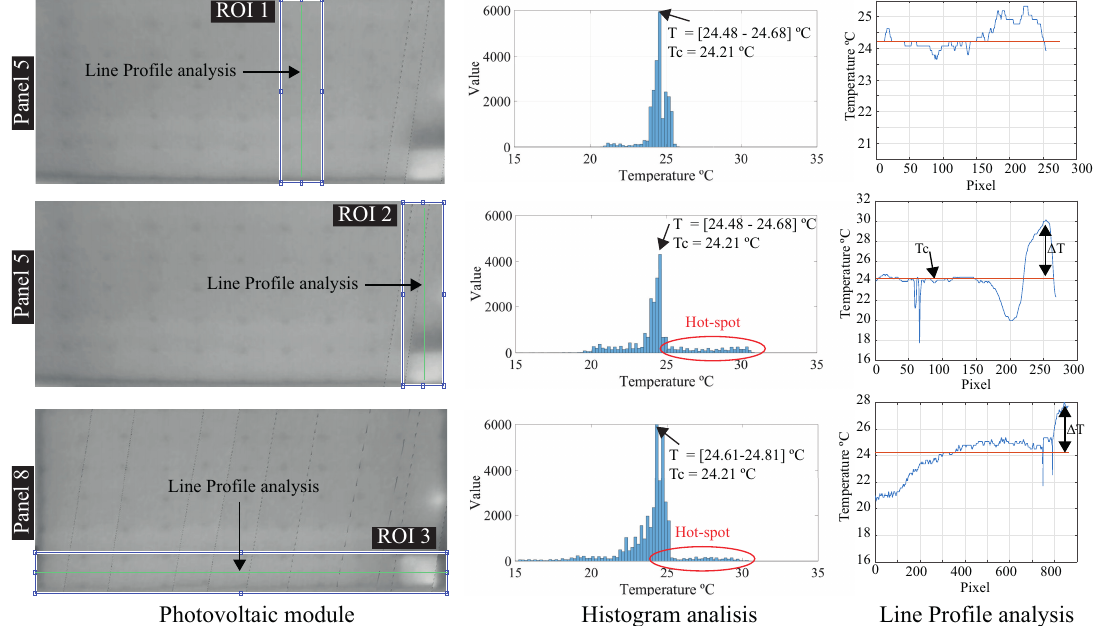
Figure 15. Results of Tsanakas’ algorithm applied to different PV-modules. Figure shows the photovoltaic module under study, the image histogram for the polygon ROI and the linear profile analysis for each